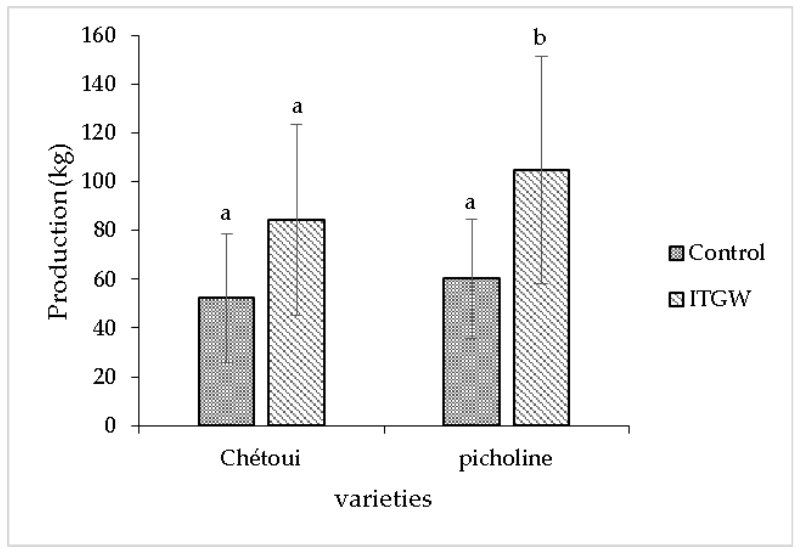
Figure 5. Average olive production of two varieties, Chétoui and Picholine, under irrigation with TGW.